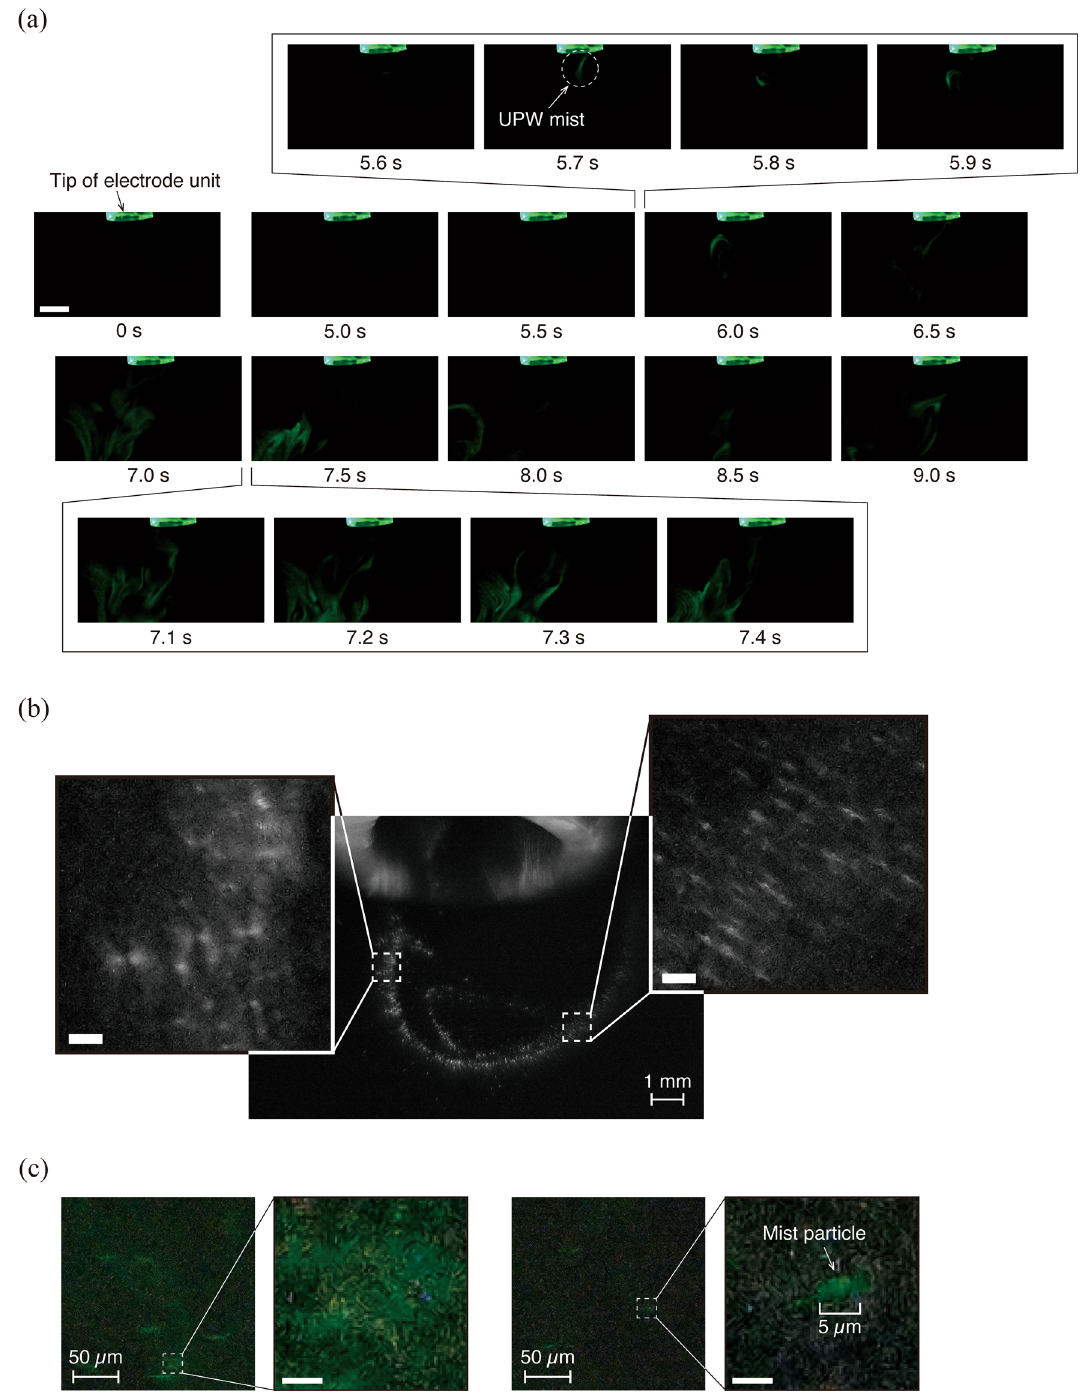
Figure 3. Nano-sized mist generated by passing a solution through DBD. ( a ) Time-course images of the UPW mist captured with a macro lens, visualized at 240 fps. The infusion rate of UPW was 50 µL/min. These images were obtained from Supplementary Movie 2. Scale bar, 5 mm. ( b ) Magnified high-speed images of the UPW mist taken with the 10 × microscope lens. Scale bars, 100 µm. ( c ) Magnified high-speed images of the UPW mist taken with the 100 × microscope lens. Scale bars, 5 µm. These images show a single frame taken at a shutter speed of 1/8000 s and an ISO sensitivity of